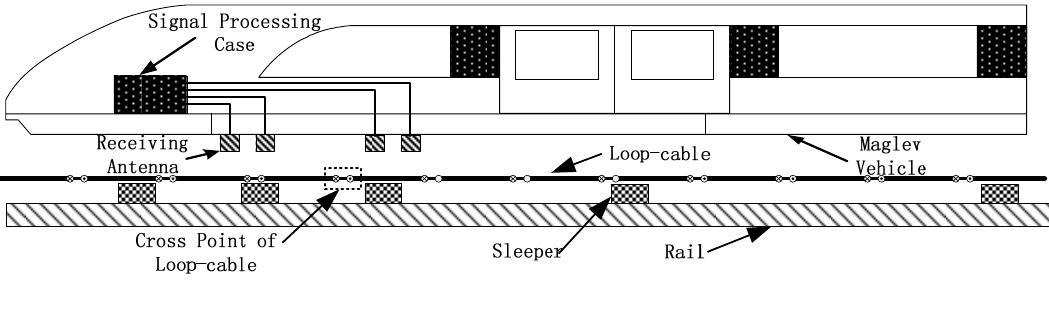
Figure 2. Loop-cable and